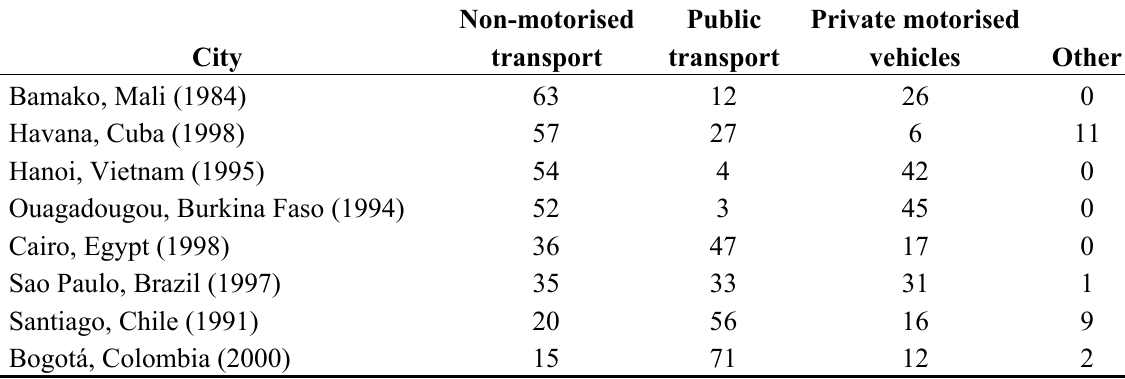
Table 4. Mode share of urban transport in selected developing